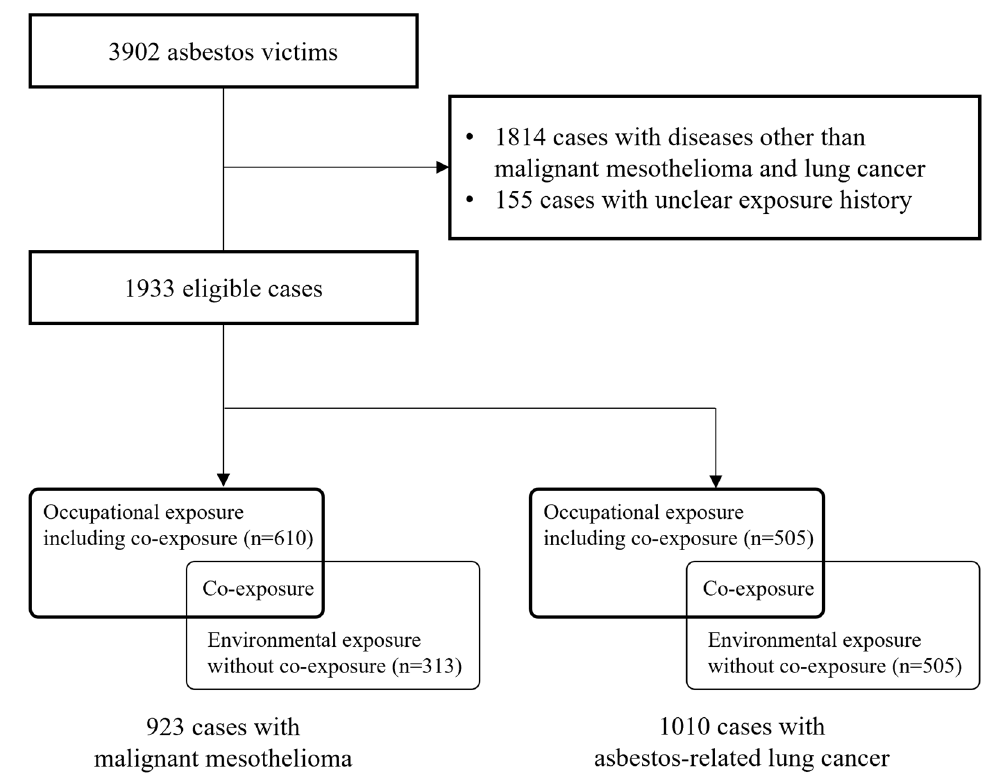
Figure 1. Flow chart describing the selection and exclusion process of study participants.